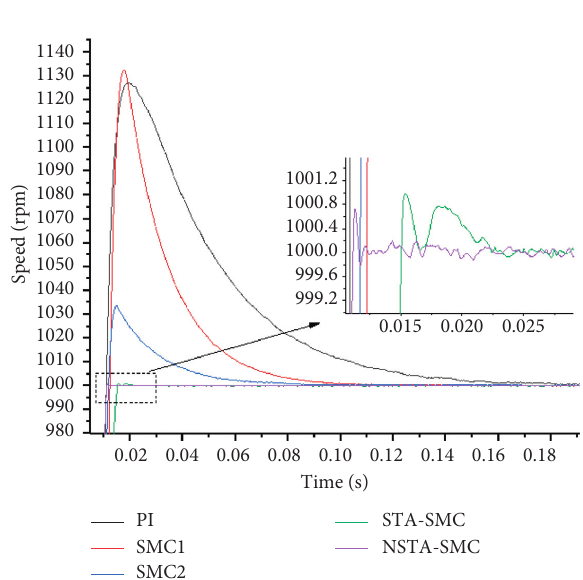
Figure 2: Speed response diagram.